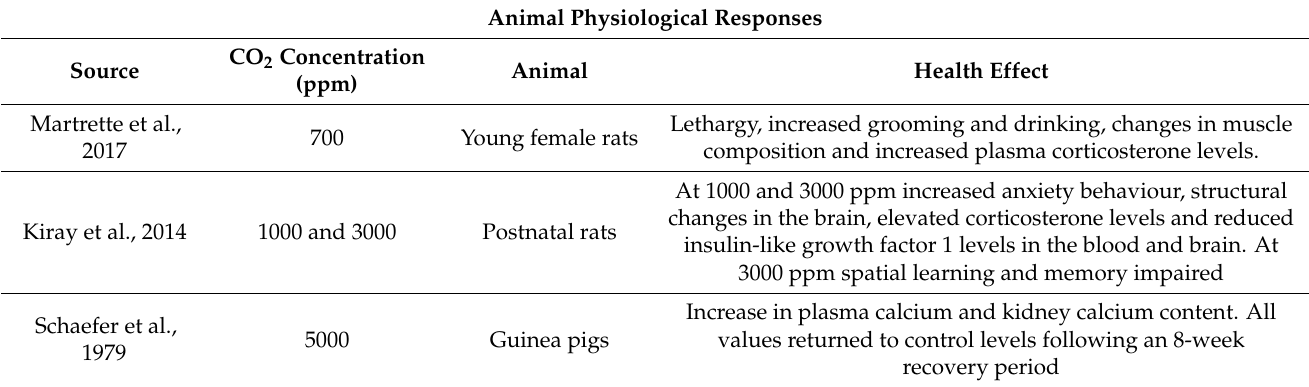
Table A6. A summary of primary research associating CO 2 with animal physiological